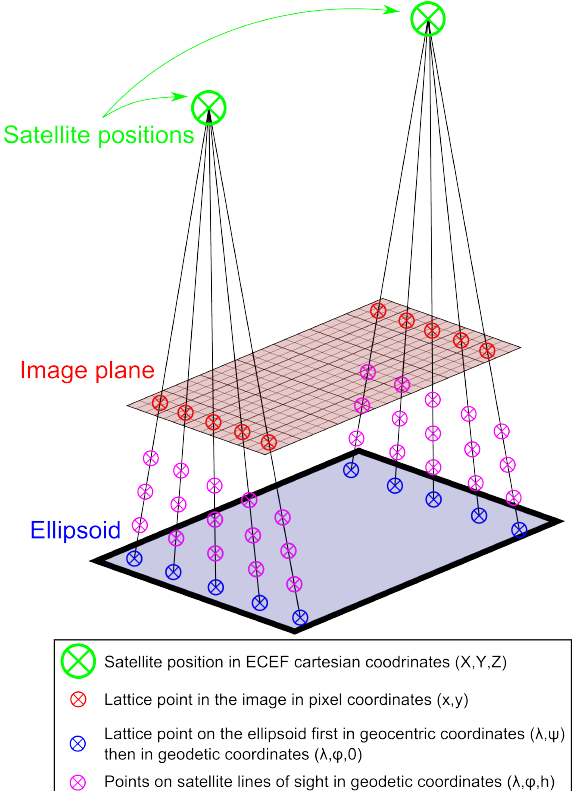
Figure 4: Satellite positions and associated lattice points in im- age and geographical coordinates and 3D GRID created from the lattice points.